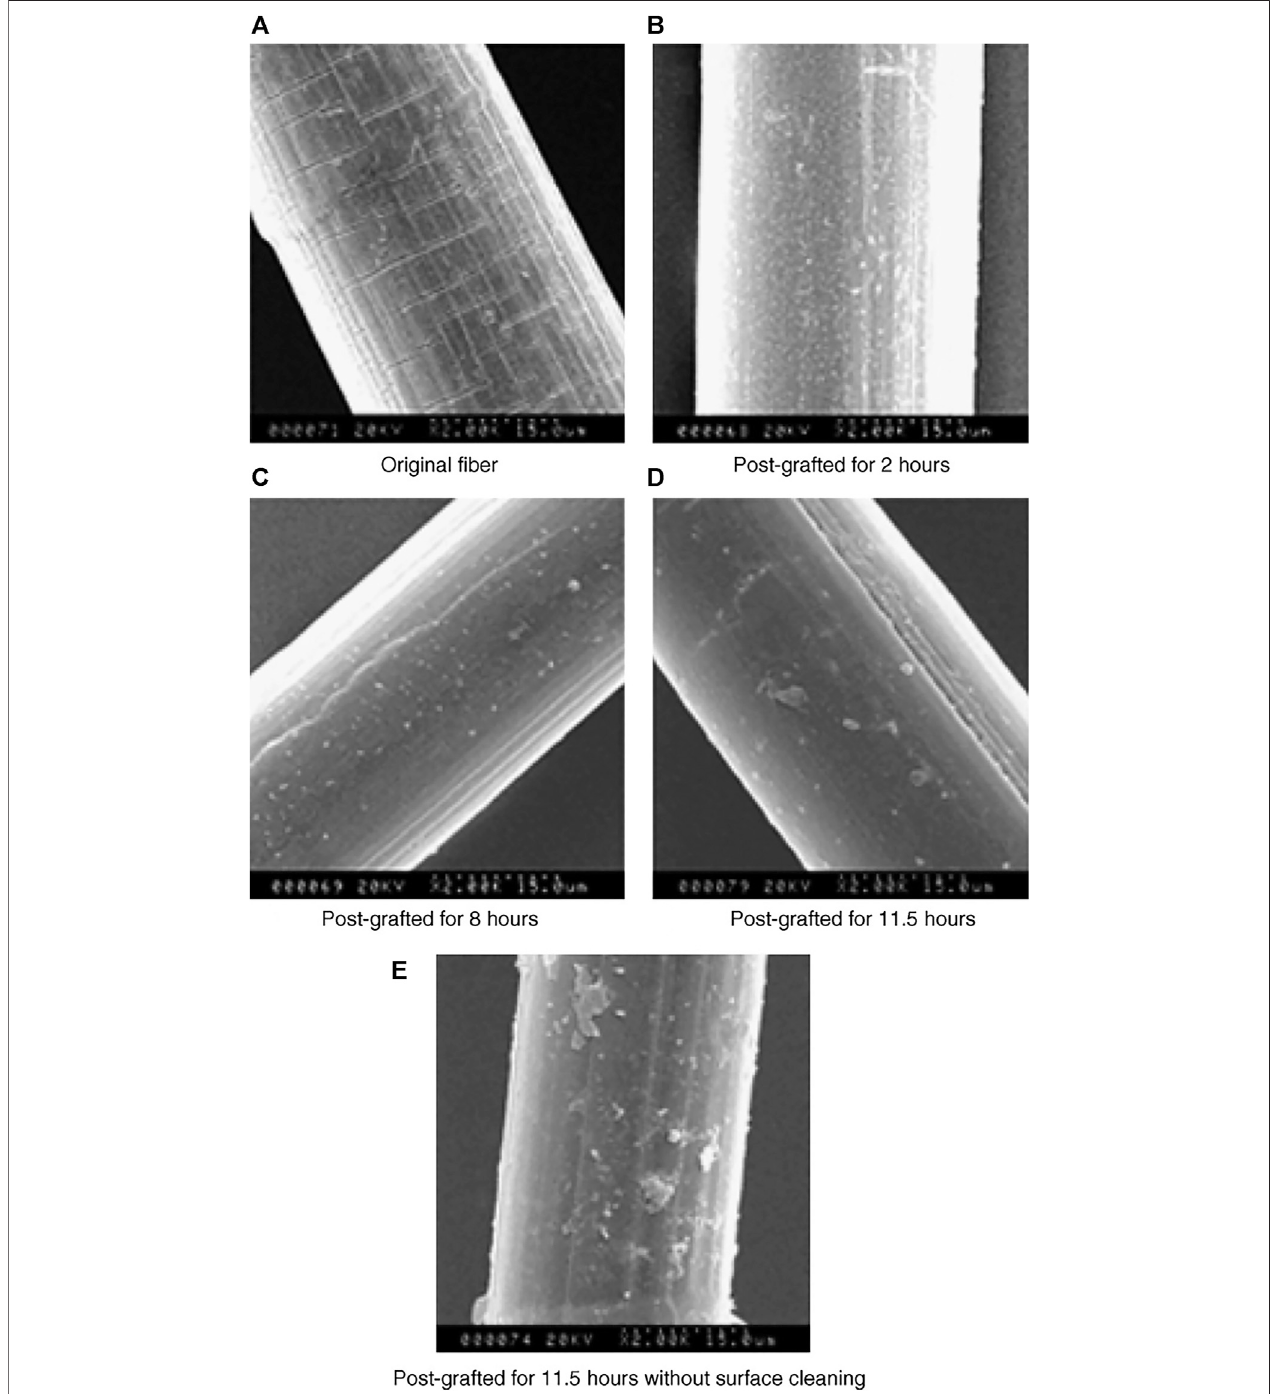
FIGURE 4 | The SEM morphology of untreated and post-grafted